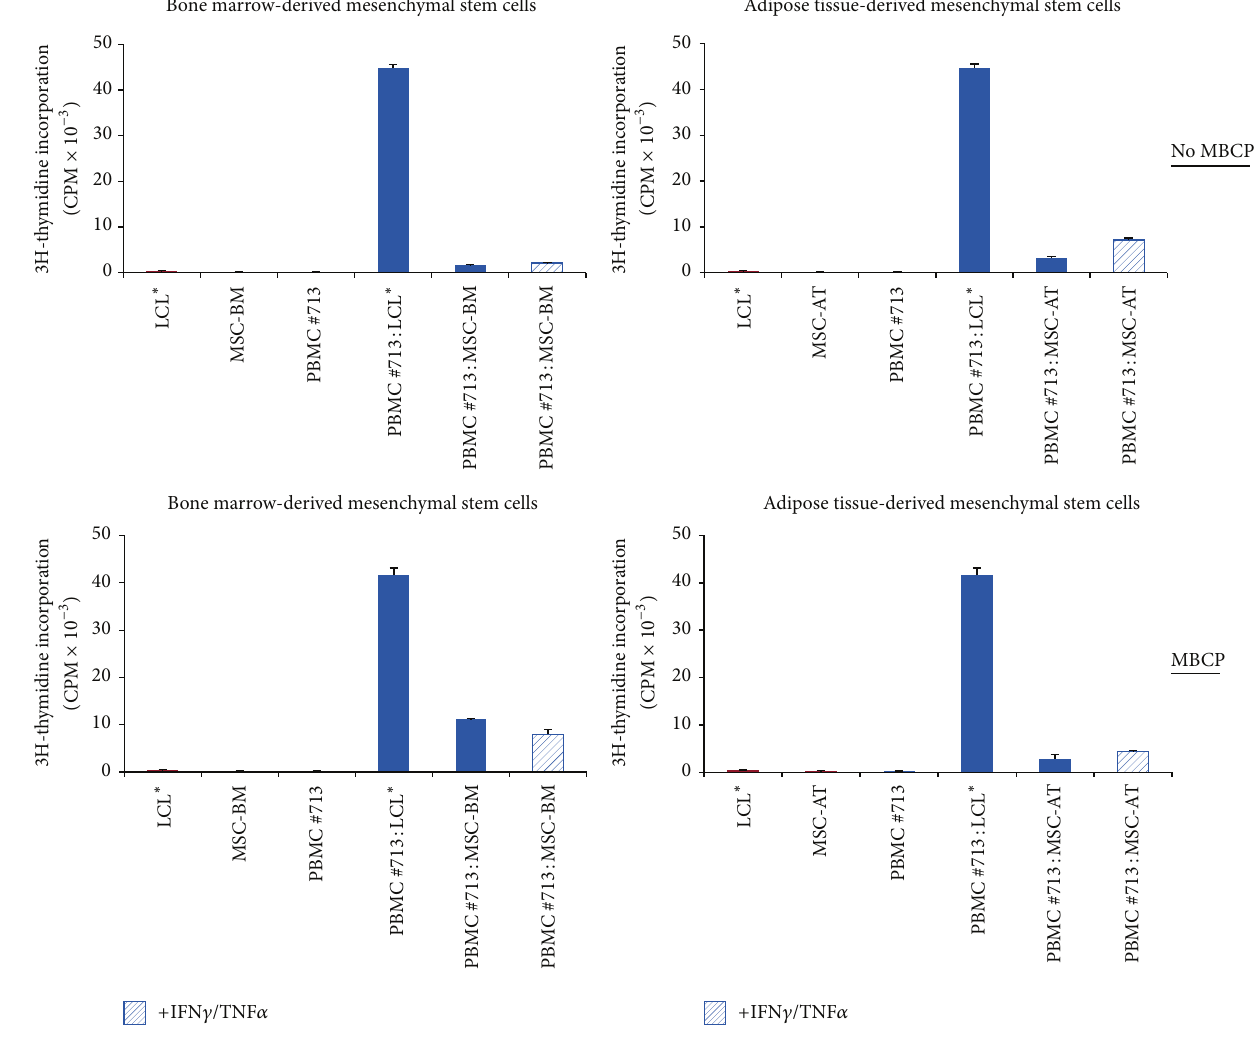
Figure 5: Both BM- andAT-derived MSCs when combined to MBCP biomaterial keep their hypoimmunogenicity. PBMC from healthy individual (#713) were used as responder cells towards either BM-derived MSCs (MSC-BM) or AT-derived MSCs (MSC-AT) that were pretreated with IFN 𝛾 and TNF 𝛼 (IFN 𝛾 /TNF 𝛼 ) or not and used as stimulating cells at the responder: stimulator ratio of 1:0.2. MSCs were combined to MBCP biomaterial (MBCP) or not (No MBCP). Irradiated LCL ∗ were used as positive control of T cell alloproliferation. Results are given as mean cpm ± s.e.m.; one representative experiment is